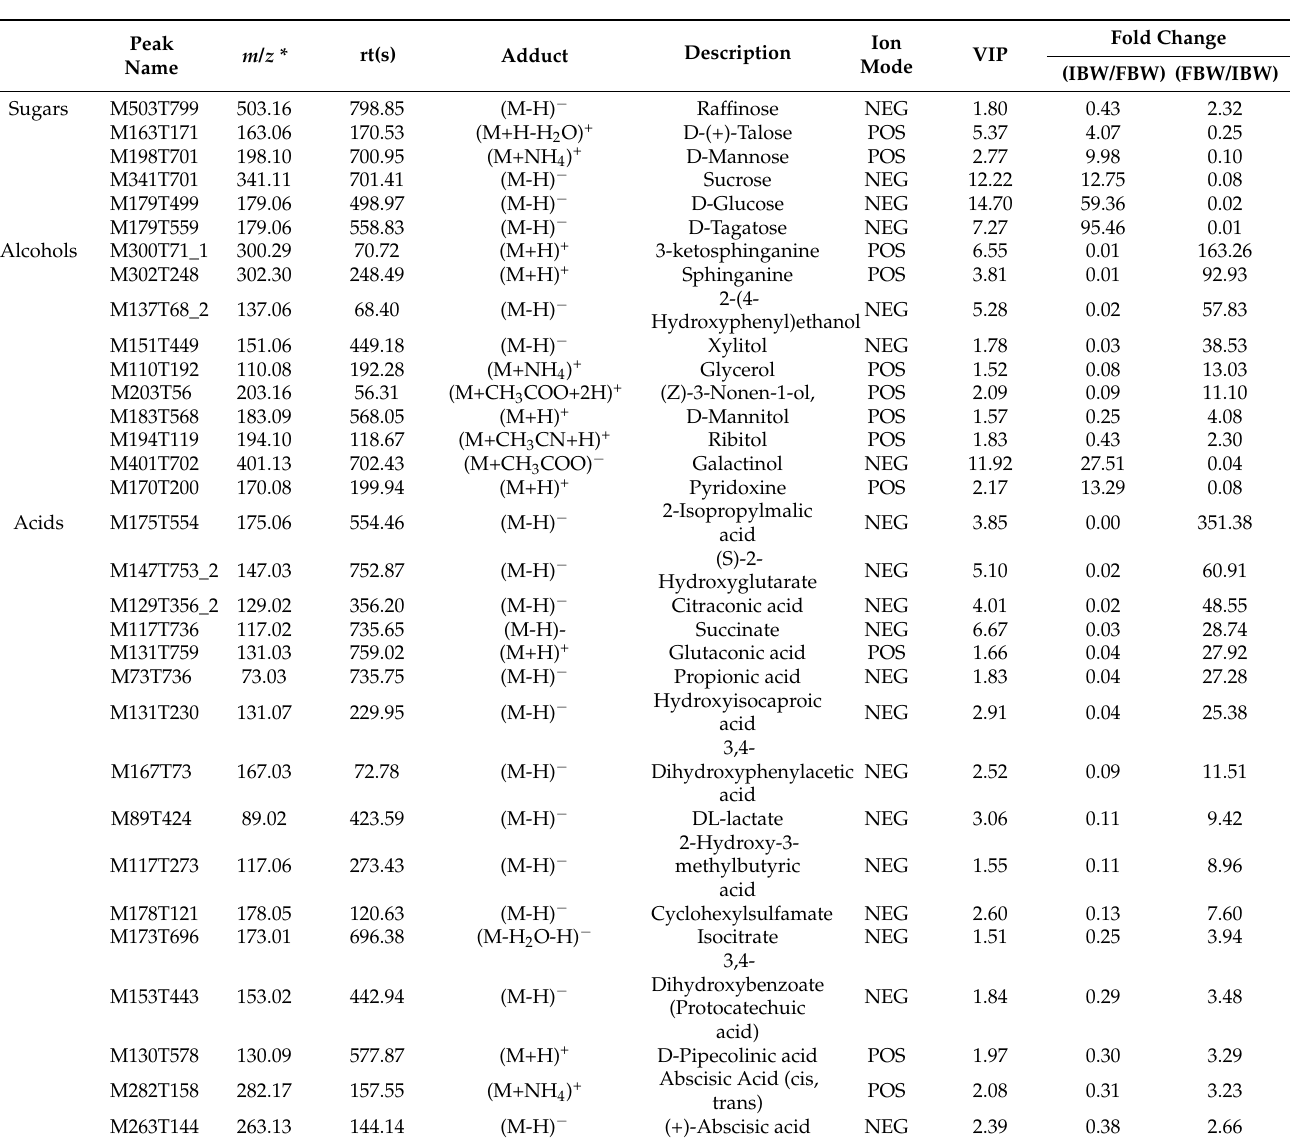
Table 4. Soluble compounds screened by variable importance in projection (VIP > 1.5), fold change (FC > 2 or FC < 0.5), and p value ( p < 0.01) of OPLS-DA